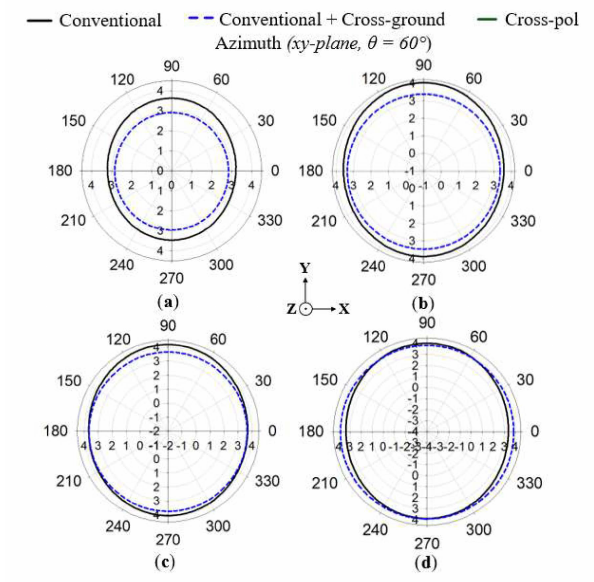
Figure 4. Simulated results of the azimuth radiation patterns for ( a ) 1.7, ( b ) 1.8, ( c ) 1.86, and ( d ) 2 GHz.